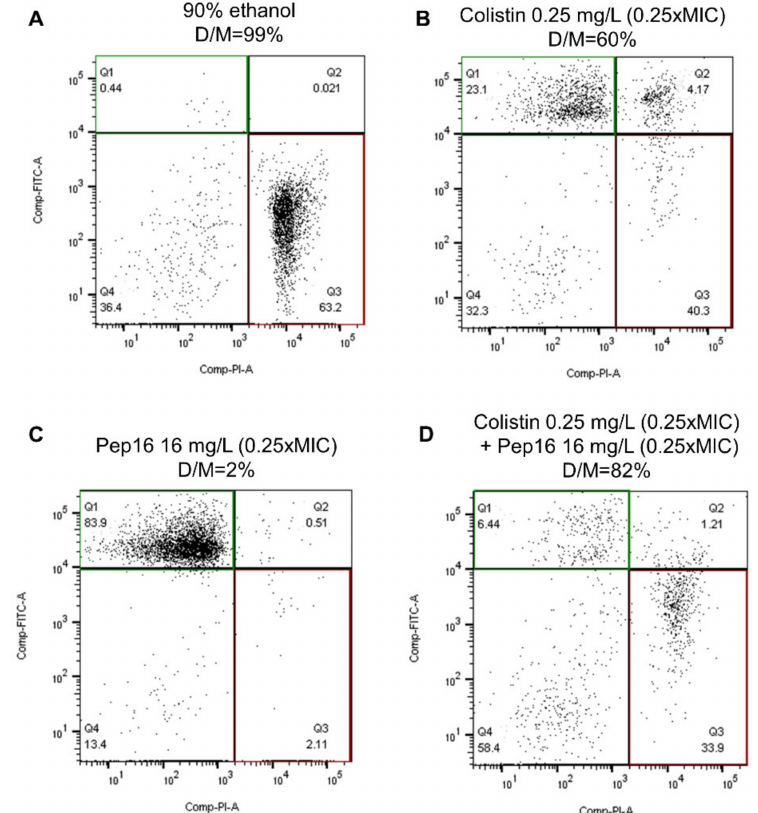
Figure 2. Flow cytometry study of membrane permeability. Bacteria showing green fluorescence have an intact membrane, and bacteria showing red fluorescence have a permeabilized